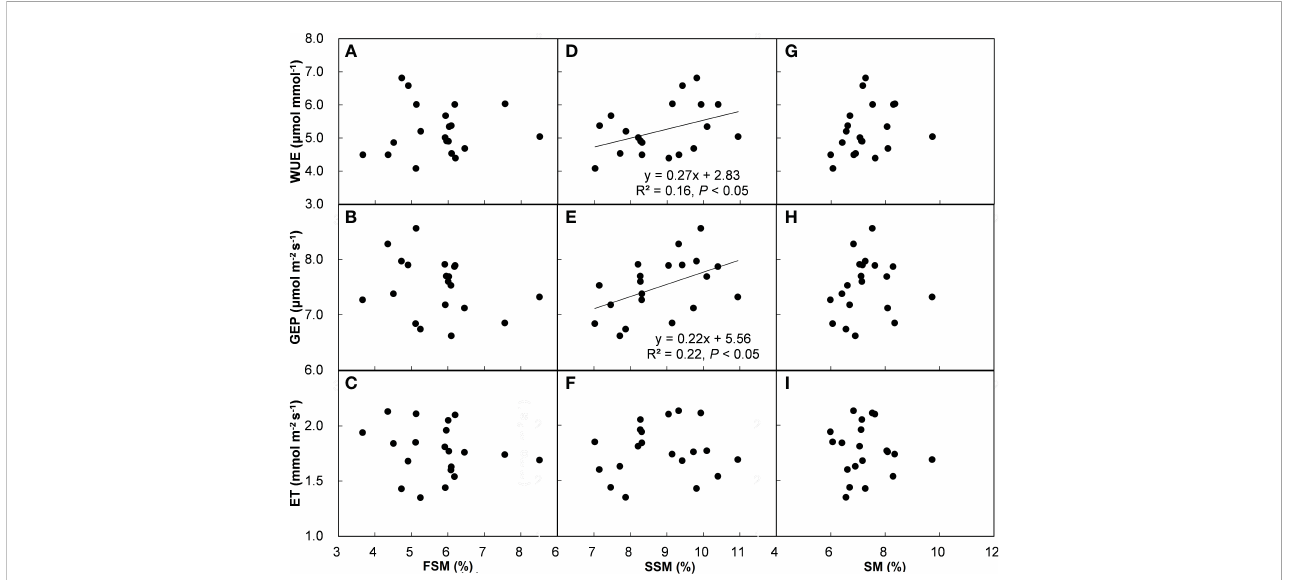
FIGURE 5 Relationships of WUE, GEP, and ET with fi rst half of (FSM) (A – C) , second half of (SSM) (D – F) , and entire (SM) (G – I) growing-season soil water content. Each point represents the average of each plot, the same in Figure